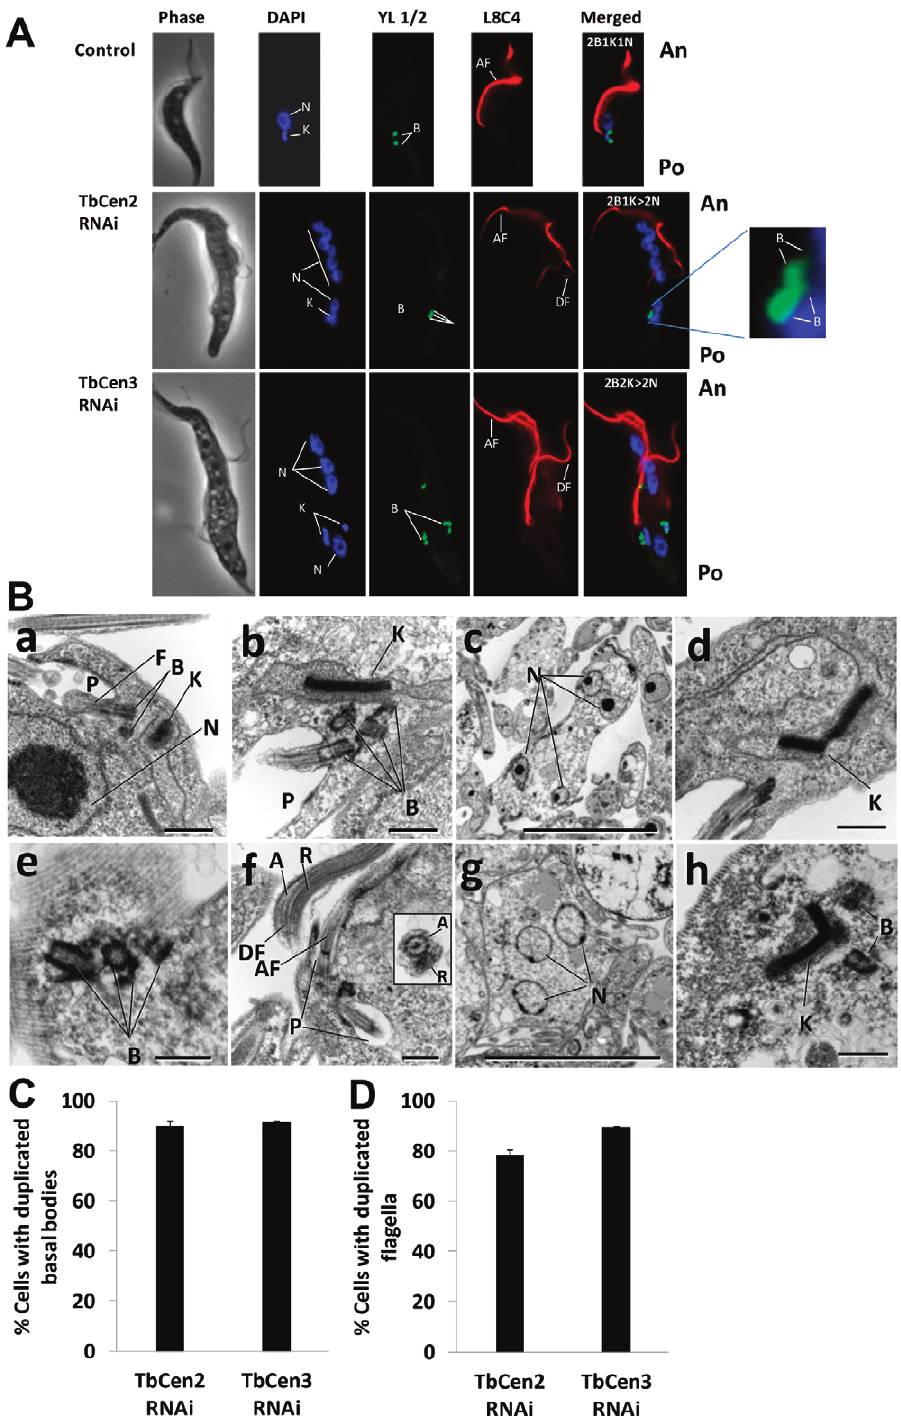
Figure 3. Effect of ablation of centrins on cell shape and organelle number. A : Effects on the duplication and segregation of basal bodies, kinetoplasts and nuclei in TbCen2 and 3-depleted cells. The cells were stained with DAPI for the nuclei and kinetoplasts, YL1/2 for the basal bodies and L8C4 for the flagella. Note the RNAi induced cells are large and pleomorphic in shape with multiple organelles with more than one flagellum and the new flagella are of detached type (middle and lower panels) compared to the control cell with organelles in single number with one attached flagellum (top panel). Scale bar, 5 m m. B : Electron microscopy of centrin-depleted cells. ( a ) A typical control cell in this particular section shows single flagellum, pair of basal bodies, kinetoplast and nucleus. ( b–d ) TbCen2-depleted cells with ( b ) multi basal bodies and the kinetoplast with enlarged size compared to the control in ‘ a ’, ( c ) multi nuclei and ( d ) abnormal kinetoplast. ( e–h ) TbCen3-depleted cells with ( e ) multi basal bodies, ( f ) multi flagella. Inset is the cross-section image of a detached flagellum displaying the normal axoneme (with 9 + 2 microtubule structure) and the paraflagellar rod, ( g ) multi nuclei and ( h ) an abnormal kinetoplast. Scale bars, 500 nm ( a , b , d–f and h ) and 2 m m ( c and g ). C & D : Bar graphs showing the percent of T. brucei procyclic cells with duplicated basal bodies ( C ) and flagella ( D ). The cells were analyzed on day 3 after induction for